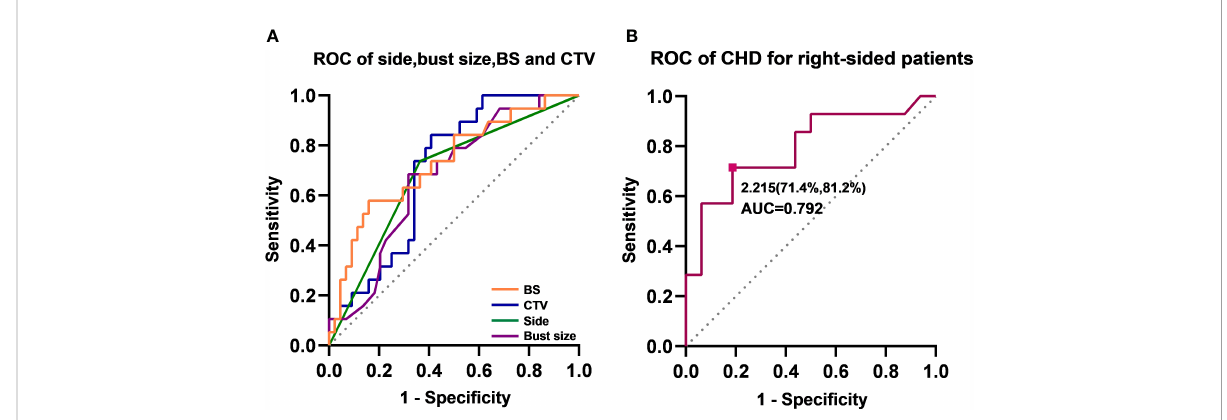
FIGURE 7 Receiver operating characteristic (ROC) curves. (A) ROC curves of side, bust size, BS and CTV. Area under the curve (AUC) of BS (orange), supine-CTV (blue), breast side (green) and bust size(purple) were 0.731, 0.702, 0.687, 0.673, respectively. (B) ROC curves of CHD for right-sided patients. The cut-off value is 2.215, with a sensitivity of 71.4% and a speci fi city of